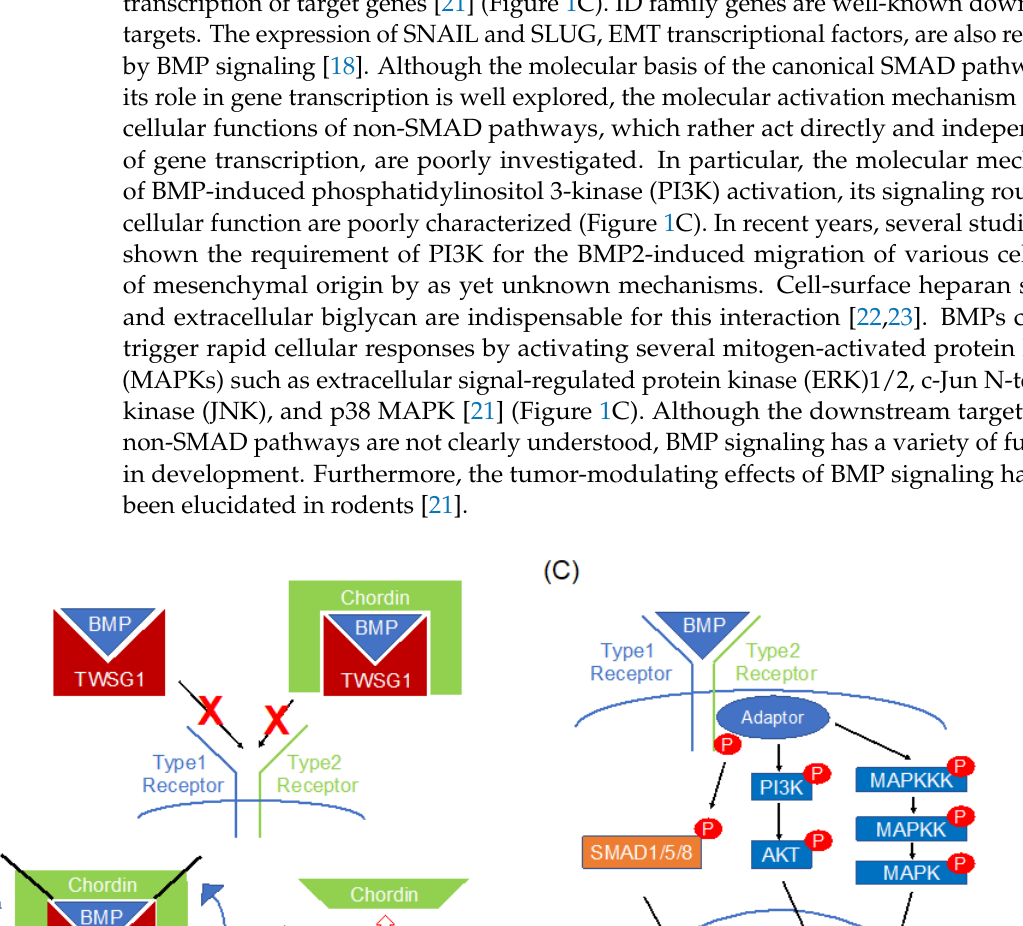
TWSG1 could have a wide range of functions. In this review, we focus on TWSG1 biology ranging from embryogenesis to cancer development (Figure